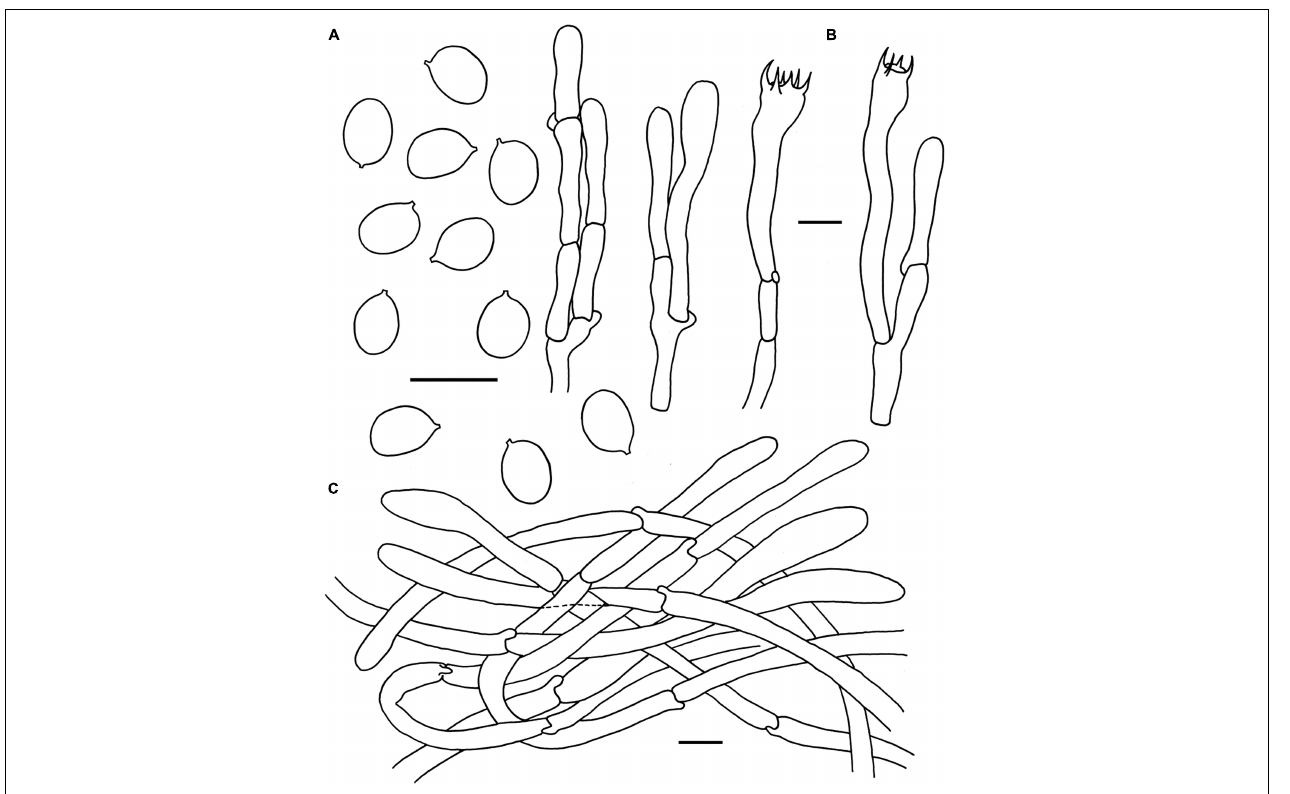
FIGURE 7 | Microscopic features of Cantharellus ravus (FHMU6845, holotype). (A) Basidiospores. (B) Basidia. (C) Pileipellis. Scale bars = 10 µ m. Drawings by Y. Z. Zhang.